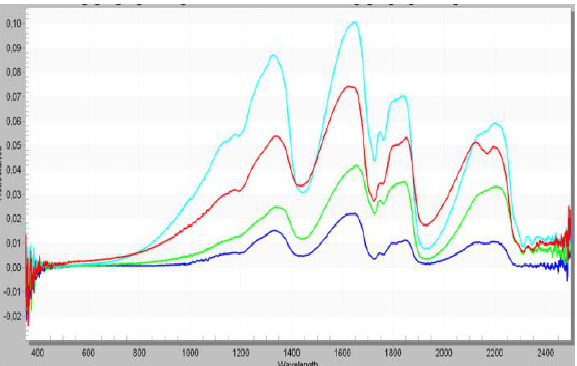
Figure 3: Reflectance spectra for four different crude oils from West Africa and North Sea, 1mm thick.